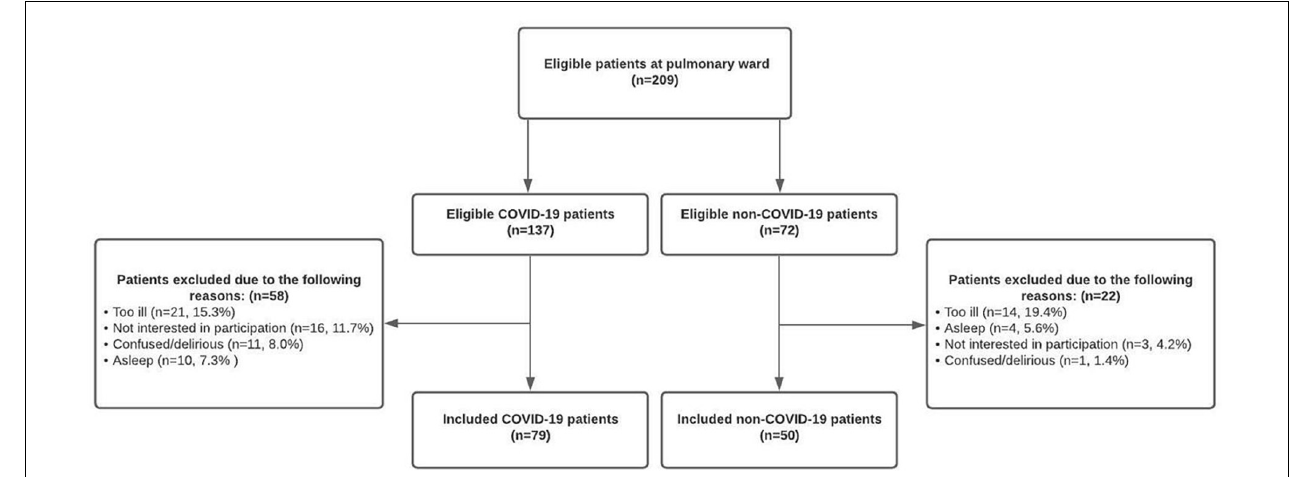
FIGURE 1 | Flowchart of patient inclusion and